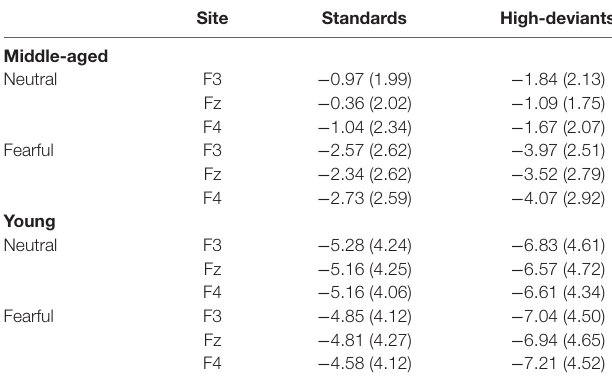
was found ( F (1,34) = 26.713, p < 0.001, η 2 = 0.440). The simple TABLE 2 | Mean amplitudes of standard and high-deviant stimuli for each p auditory condition ( µ V with SD) in young adults and middle-aged